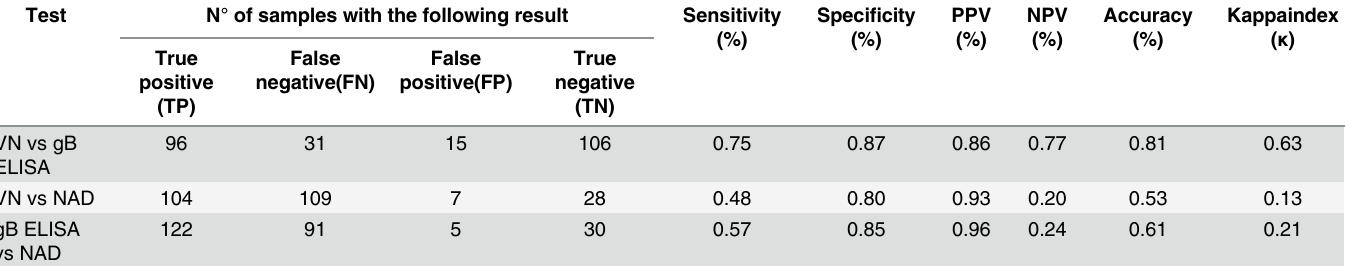
Table 2. Comparison between results of: Virus neutralization (VN) and gB ELISA; VN and nucleic acid detection (NAD); NAD and gB ELISA. Sensi- tivity, specificity, negative (NPV) and positive (PPV) predictive values (CI = 95%) are shown. Test N° of samples with the following result